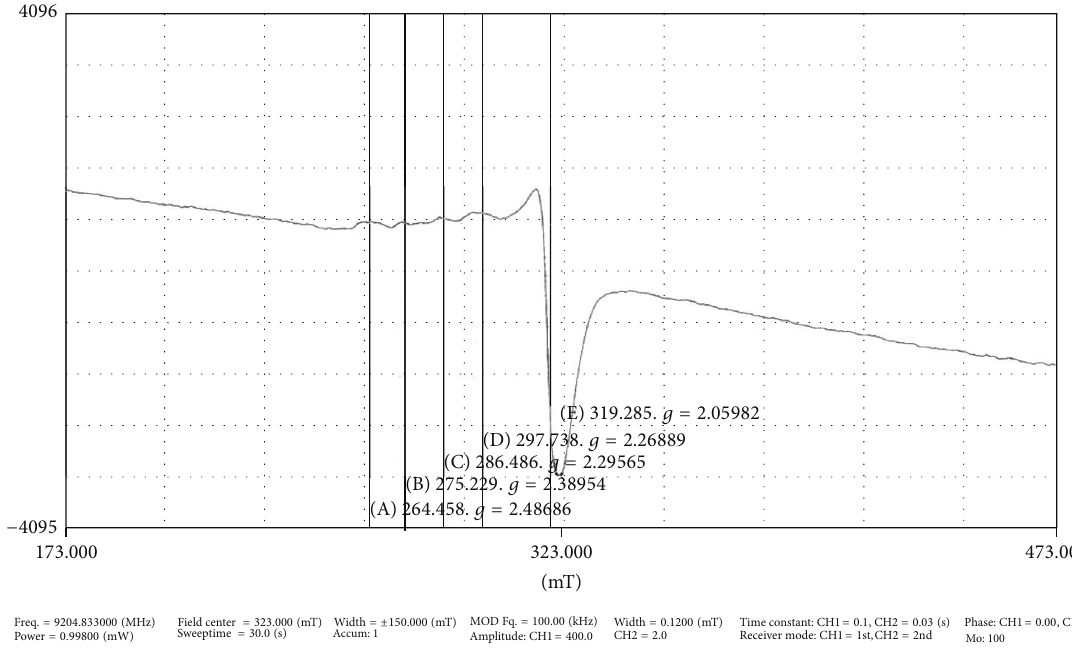
Figure 3: EPR spectrum of copper complex at 77 K.